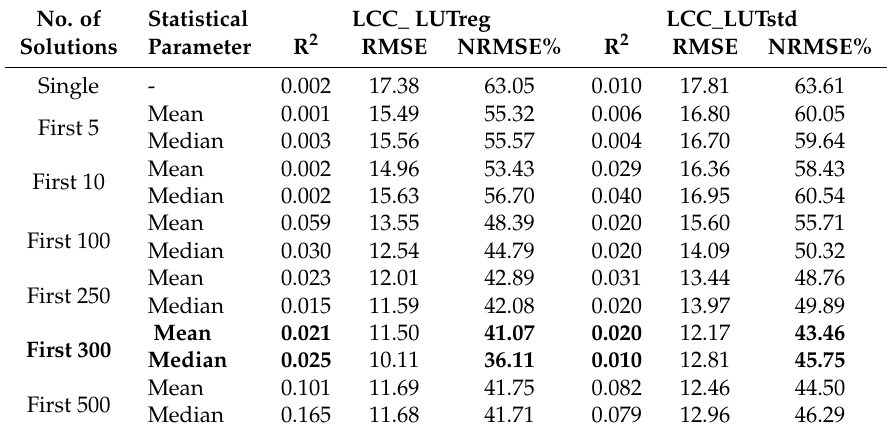
Table A1. Retrieval parameters from LUT scenarios for single and multiple solutions.